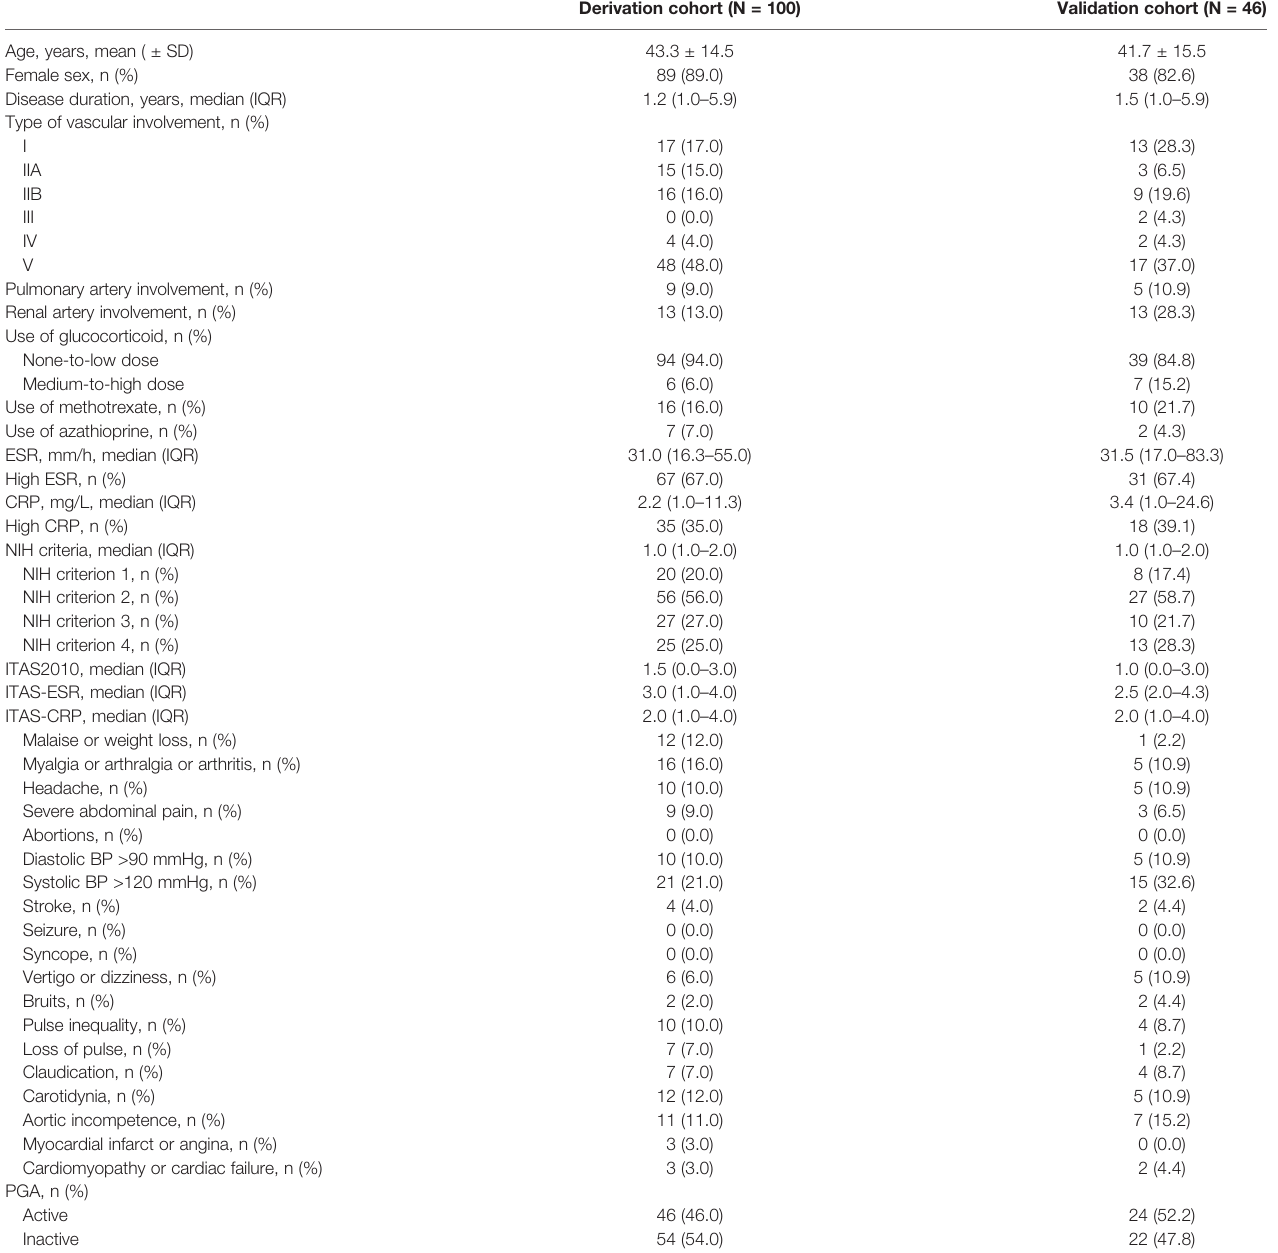
TABLE 1 | Characteristics of the patients at the time of disease activity